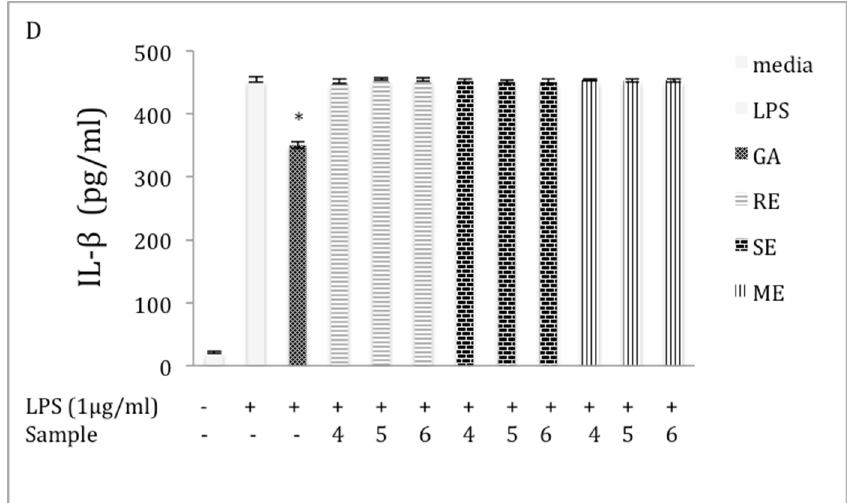
Figure 5. Effect of extracts and phenolics on IL- β expression in macrophage RAW 264.7 cells ( A ) extracts obtained by ASE; ( B ) pure phenolic acid standards; ( C ) crude polysaccharide extracts; and ( D ) different extraction methods. Cells were cultured in the absence or presence of LPS (1 μ g /mL) with various concentrations of different samples for 24 h (0 = media; GA = 2 μ M; 1= 5 μ M; 2 = 10 μ M; 3= 20 μ M; 4 = 50 μ g/mL; 5 = 100 μ g/mL; and 6= 150 μ g/mL; 7= 25 μ M; 8 = 50 μ M; and 9 = 100 μ M). IL- β production was determined through an ELISA. The data represent the mean ± SD of triplicate experiments. Statistical significance p < 0.05 (*) was determined using one-way analysis of variance for independent means, followed by Tukey’s HSD test.